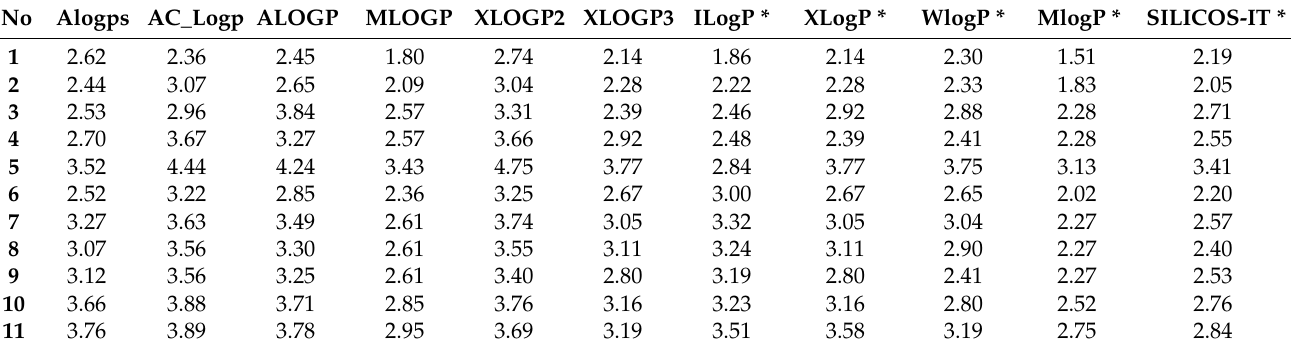
Table 1. The calculated lipophilic parameters ( logP calcd ) for 1,9-dipyridothiazine 1 – 10 using